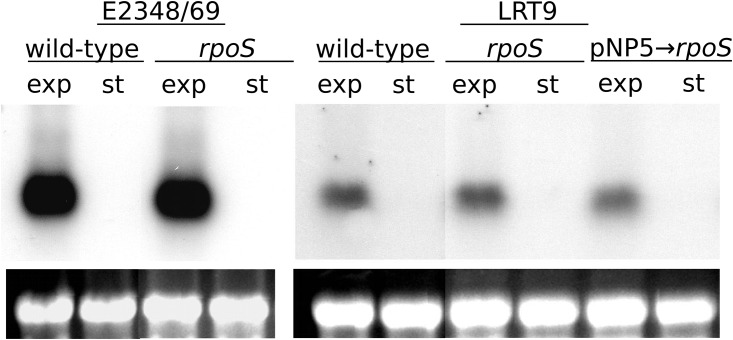
Effect of rpoS on the expression of bfpA.RNA extracted from E2348/69, LRT9, from their respective rpoS∷Tn10 mutants and from the rpoS∷Tn10 transformed with pNP5 (rpoS+) at the mid-exponential (exp) phase and at the beginning of the stationary phase (st) was hybridized with a labeled bfpA probe. The observed bands correspond to the bfpA transcript (0.6 Kb) and below to the 23S rRNA. The bright bands shown below the blot are the 23S rRNA stained with ethidium bromide. Each blot was repeated at least twice.